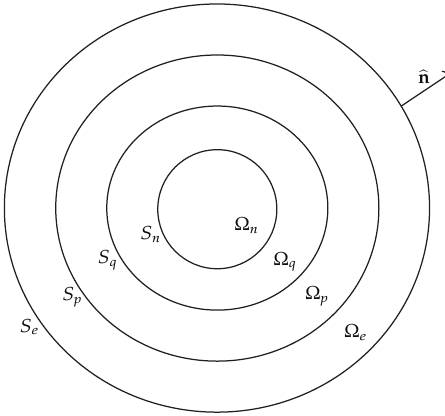
Figure 1: The spherical domains of the tumour growth